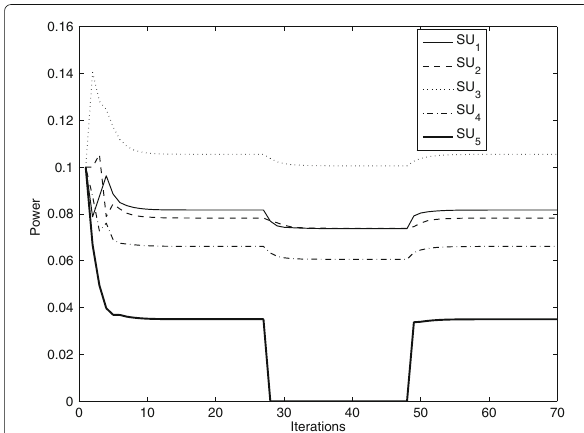
Fig. 5 The variations of SINRs versus the number of iterations for variable target SINRs